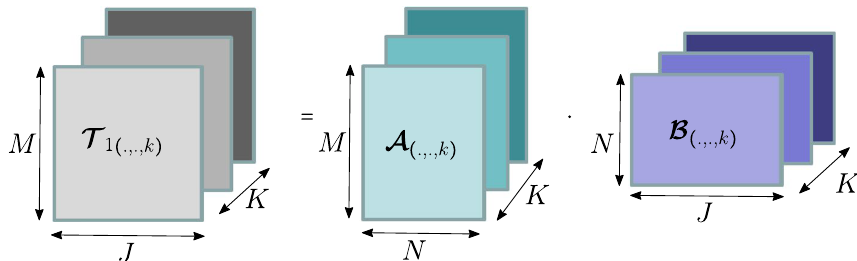
Fig. 1 A slice-wise multiplication between two tensors A ∈ C M × N × K and B ∈ C N × J ×